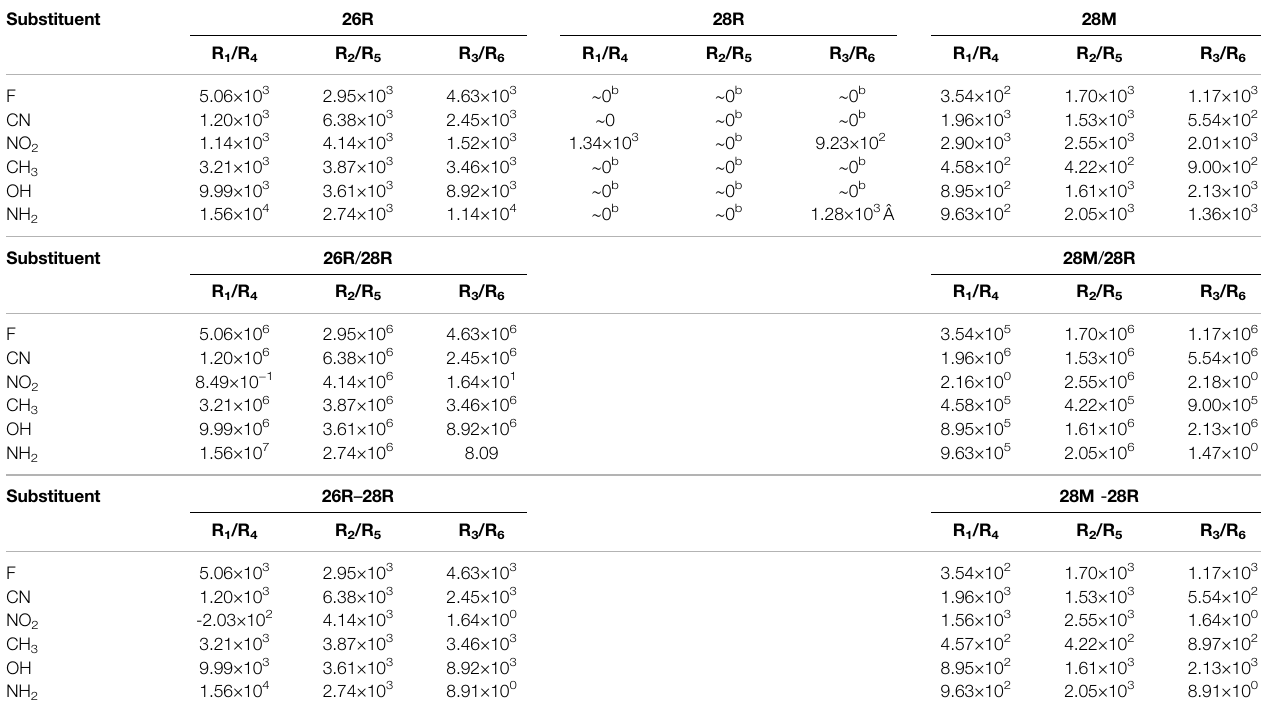
TABLE 3 | The β HRS response a of meso -substituted hexaphyrins ’ individual sites (R 1 /R 4 , R 2 /R 5 and R 3 /R 6 ) and their corresponding contrasts using both the ratio and difference de fi nition. Substituent